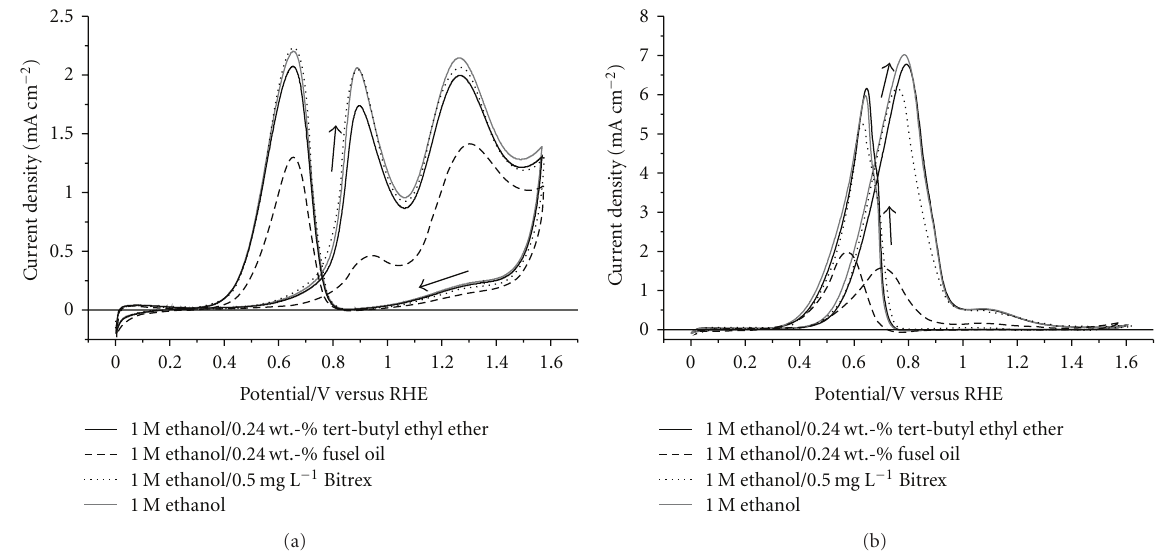
Figure 3: Cyclic voltammetry of ethanol and denatured ethanol solutions in 0.5 M H 2 SO 4 (a) and 0.1 M KOH (b). 1M ethanol + 0.24 wt.-% ETBE (line), 1M ethanol + 0.24wt.-% fusel oil (dashed), and 1M ethanol + 0.5 mgL − 1 Bitrex (dotted) and 1M ethanol (grey line). Scan rate 50 mVs − 1